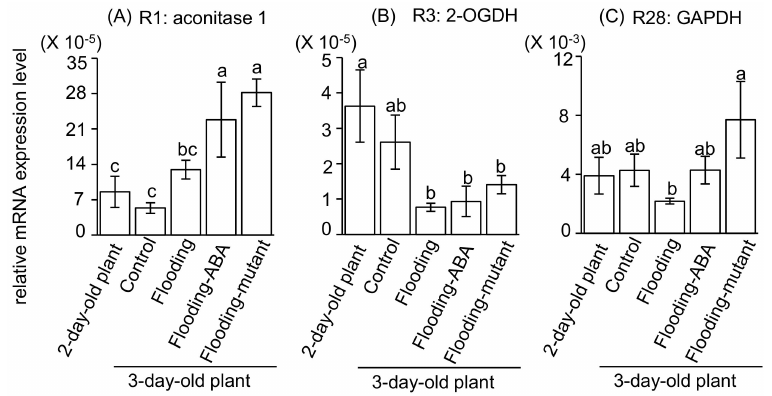
Figure 7. Gene expression of aconitase 1,2-oxoglutarate dehydrogenase, and glyceraldehyde-3-phosphate dehydrogenase in soybean at an early stage of flooding. ( A ) Gene expression of aconitase 1 (R1) in soybean at an early stage of flooding; ( B ) Gene expression of 2-oxoglutarate dehydrogenase (R3) in soybean at an early stage of flooding; ( C ) Gene expression of glyceraldehyde-3-phosphate dehydrogenase (R28) in soybean at an early stage of flooding. Two-day-old wild-type soybean plants were treated without or with flooding for one day. For ABA treatment, 10 µ M ABA was supplied to wild-type soybean exposed to flooding at the same time. Two-day-old flood-tolerant mutant plants were exposed to flooding for one day. Unstressed wild-type soybean plants served as controls. Root samples (including the hypocotyl) were collected for mRNA extraction. qRT-PCR was performed and gene expression was normalized against 18S rRNA. Data shown are means ± SD from three independent biological replications. Different letters indicate statistically significant difference ( p < 0.05, one-way ANOVA followed by Tukey’s multiple comparison test). Abbreviations are as follows: 2-OGDH, 2-oxoglutarate dehydrogenase; GAPDH, glyceraldehyde-3-phosphate